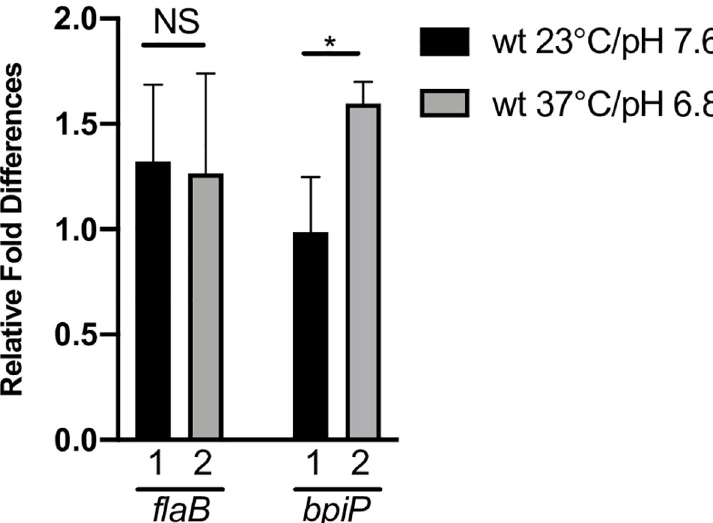
Fig 4. Transcriptional analysis of bpiP . (A) Total RNA from wt grown at pH7.6/23˚C or pH6.8/37˚C was converted to cDNA and quantitative real-time PCR was performed as described in the Materials and Methods. The value for each sample was normalized to the value of recA and change in the C value for flaB or bpiP shown is an average of three t replicates. The ΔΔ C t values are shown as fold difference. The asterisk indicates the levels of significance as follows: � p < 0.05.